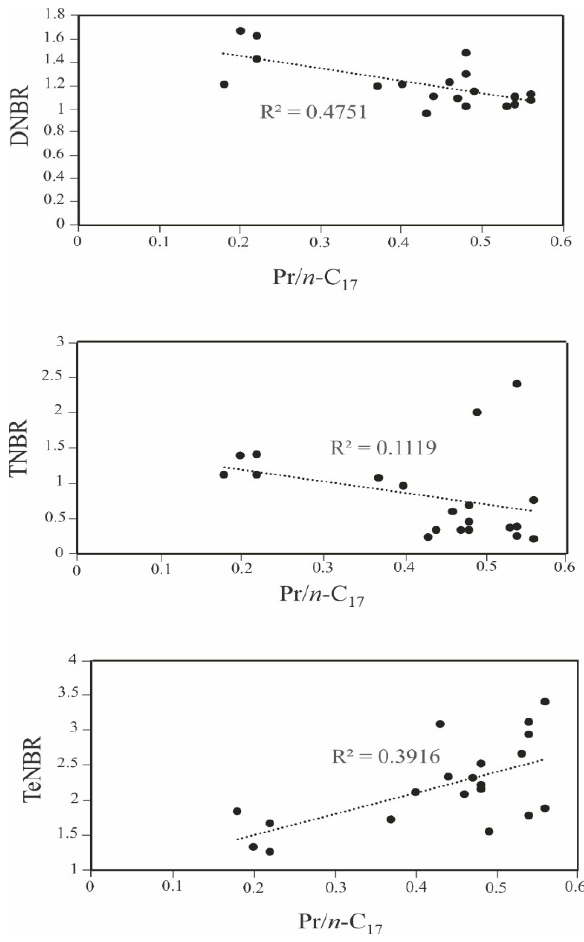
Figure 9. DNBR (DNBR:1,6/1,5), TNBR (TNBR:1,3,7/1,2,7), and TeNBR (TeNBR:1,3,6,7/1,3,5,7) biodegradation ratios vs. Pr/ n -C 17 of 20 oil samples from Tarim Basin.